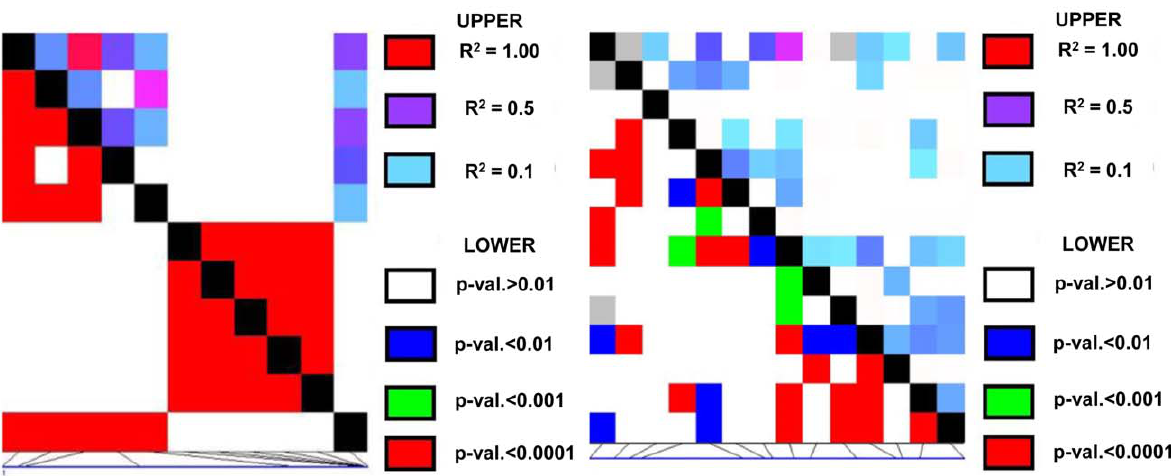
Figure 5. LD patterns in the C-terminus exon of ZmLOX4 (left) and ZmLOX5 (right). LD plots of SNPs found via Sanger sequencing (outlined in Figures 1 and 2, and Table 1) based on ZmLOX4 with 6 SNPs and 1 InDel, spanning a total of 663 bp in the final 3 9 exon across 260 diverse inbred lines, and ZmLOX5 with 14 SNPs, spanning 709 bp across 203 diverse inbred lines. Both show a rapid ( , 100 bp) decay of LD (r 2 . 0.1).